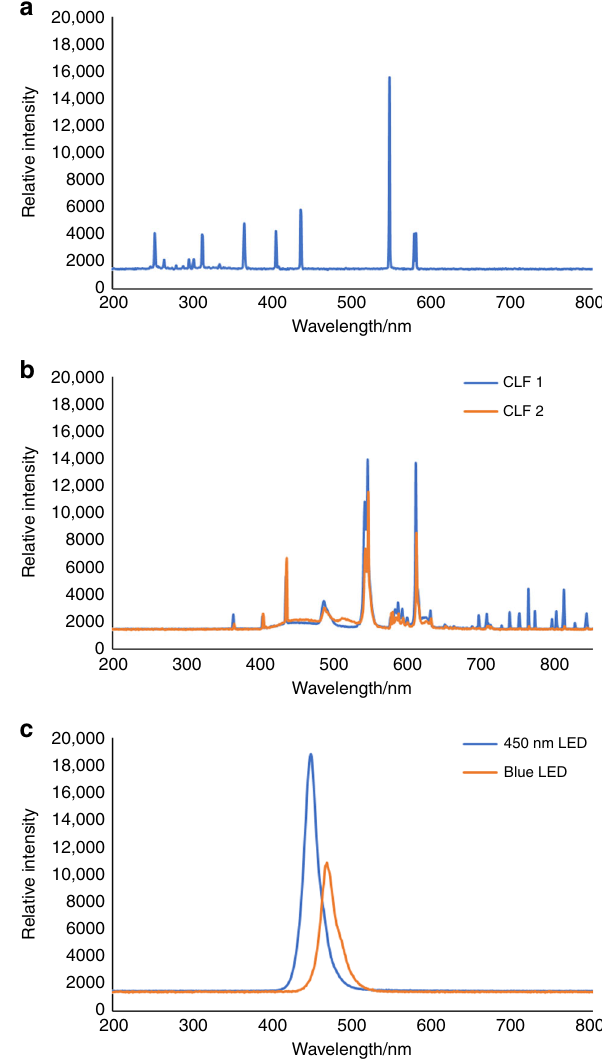
Fig. 2 Comparison of the spectral outputs and relative light intensities of commonly used light sources. a 12 W medium pressure mercury lamp; b two CFLs (overlaid); c a 450 nm LED fl ow reactor, and a blue LED screening platform at 30 mA (overlaid). Figure adapted from (https://doi. org/10.1002/cptc.201900203). Copyright Wiley-VCH Verlag GmbH & Co. KGaA. Reproduced with